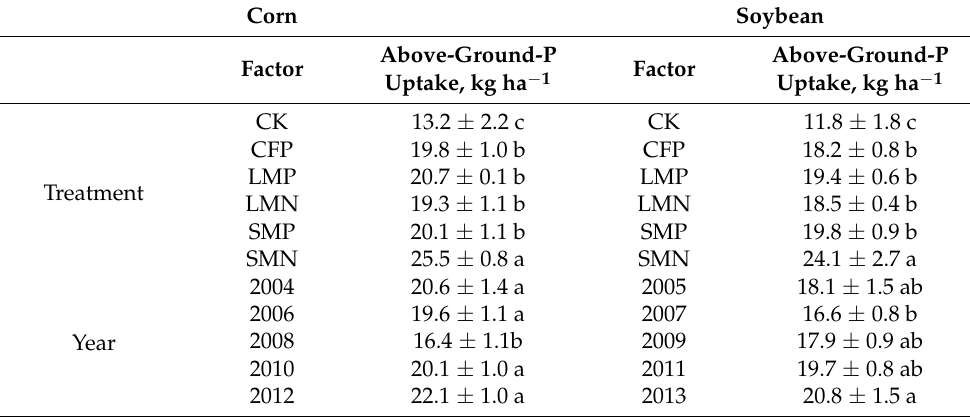
Means followed by the same letter within a column are not significantly different at p ≤ 0.05